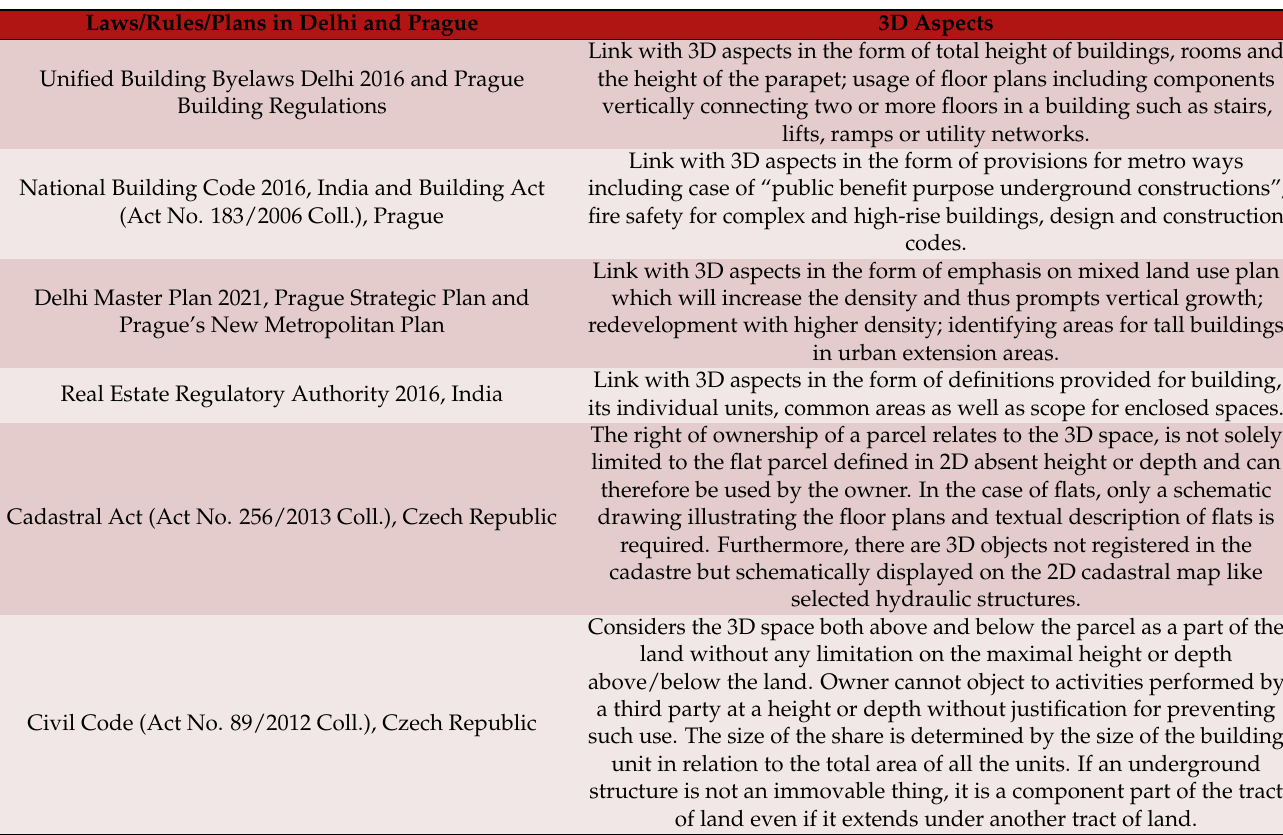
Table 3. Legal and planning aspects related to 3D in Delhi and Prague.